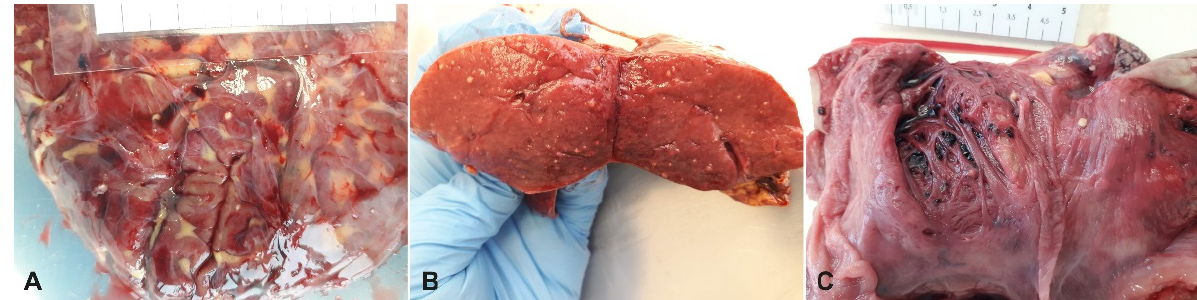
Figure 2. Yellow foci of necrosis in kidneys ( A ), spleen ( B ), and cardiac tissue ( C ).